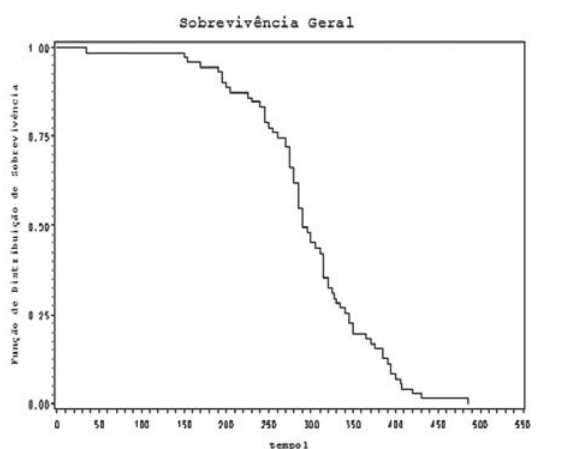
Fig. 1 - Sobrevivência Geral – tempo 1: T1 - Tempo Real da Operação (minutos)